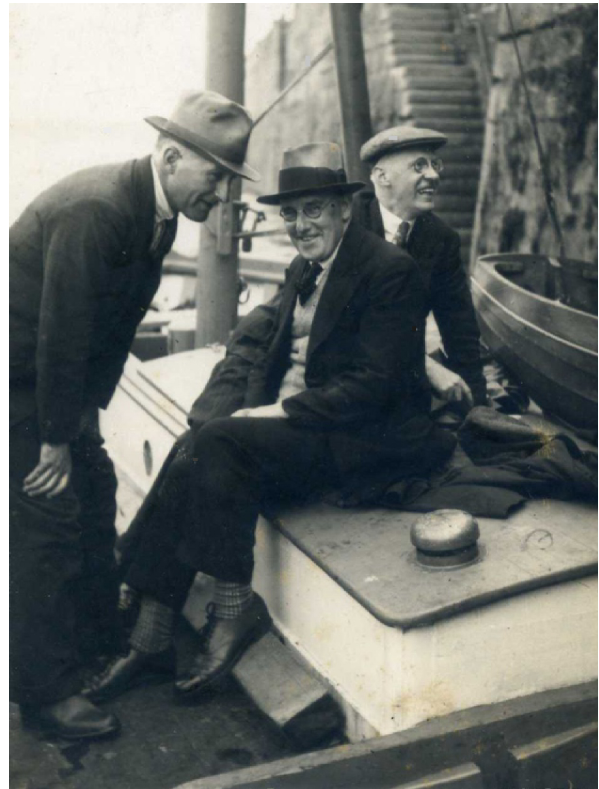
Figure 2. Joseph Proudman (right), Arthur Doodson (centre) and Richard Daniel, a marine biologist from Liverpool University (left), during an Irish Sea cruise in the late 1930s aboard the Zephyr . Pho- tograph courtesy of Valerie Gane. Other photographs of Doodson may be found in Carlsson-Hyslop (2020) and Woodworth (2020a).